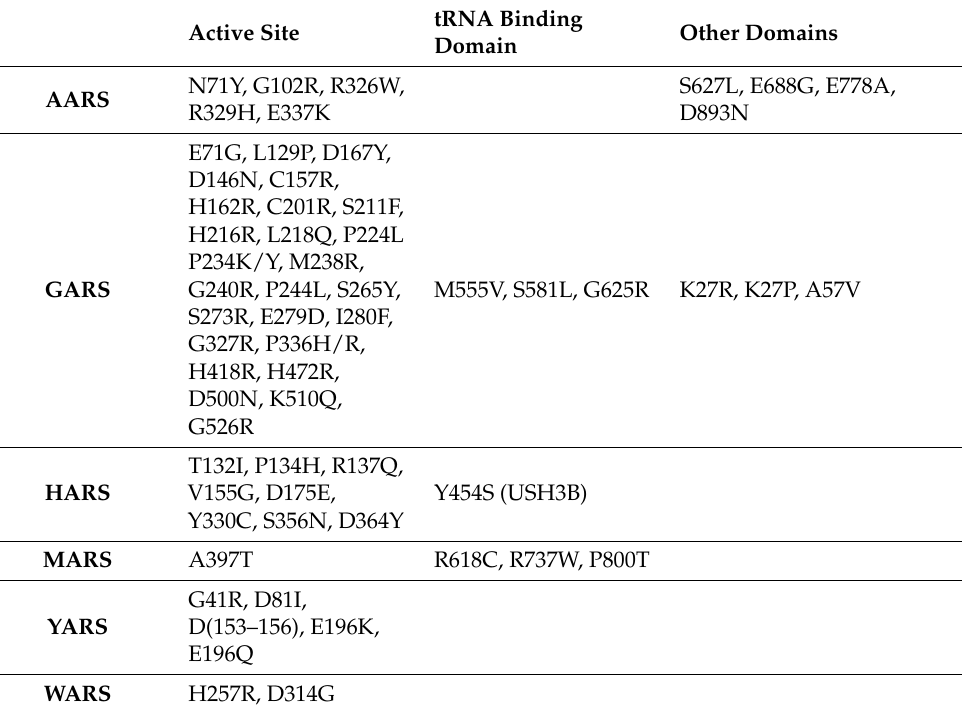
Table 2. CMT disease-associated mutations in